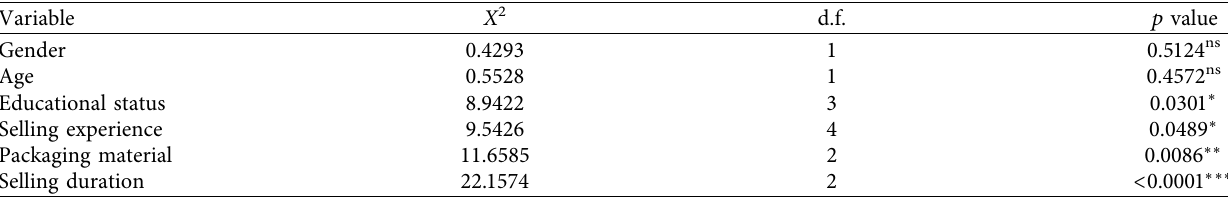
Table 2: Chi-square result for losses of fruits and vegetables after harvest and sociodemographic factors and postharvest handlings